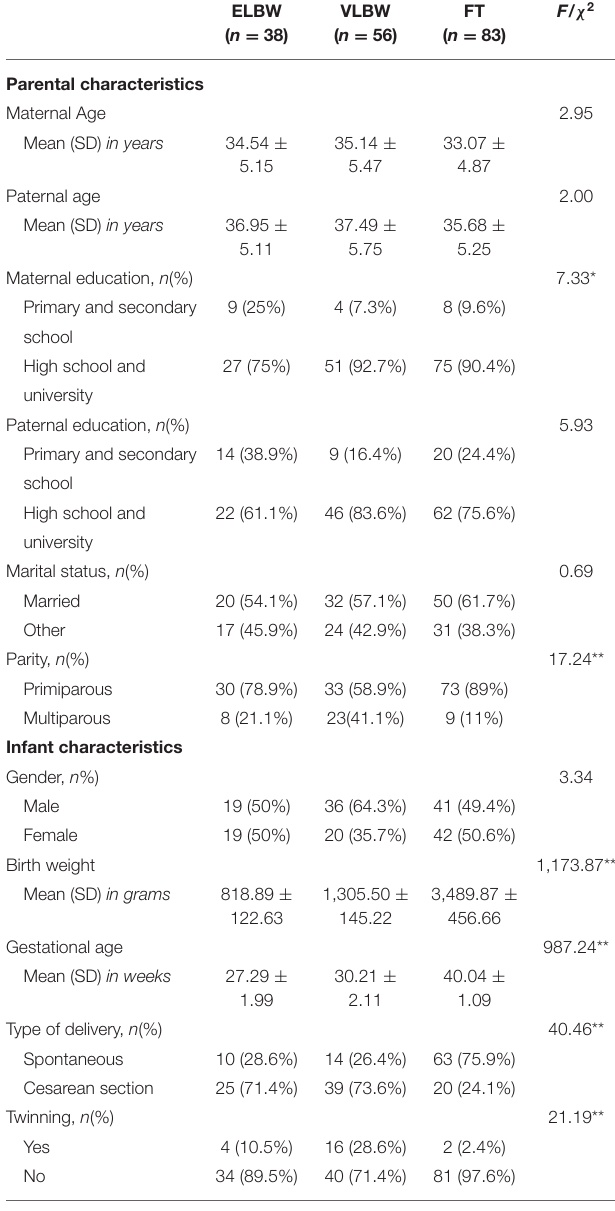
TABLE 1 | Parents and infant characteristics according to categories of birth